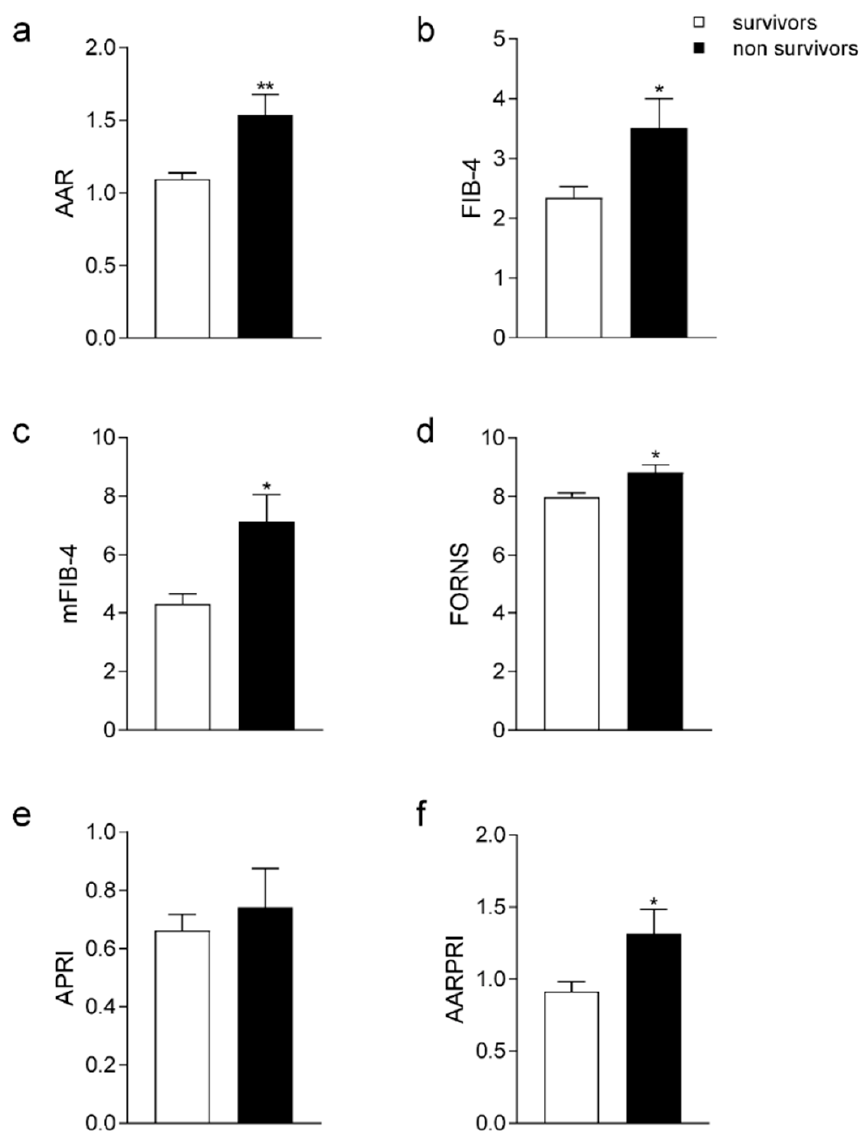
Figure 1. Comparison of Liver Fibrosis Scores in survivor and non survivor patients. Comparison of AAR ( a ), FIB-4 ( b ), mFIB-4 ( c ), FORNS ( d ), APRI ( e ), AARPRI ( f ) scores between survivors and non survivors. Data are presented as mean ± SEM. Statistical significance was assessed by Student t -test (* p < 0.05, ** p < 0.001). Abbreviations: AST to ALT ratio: AAR; fibrosis-4 index: FIB-4; modified FIB-4: mFIB-4; AST to Platelet Ratio Index: APRI; AAR to Platelet ratio: AARPRI. 3.2. Liver Fibrosis Scores among Discharged, Admitted to Intensive Care Unit (ICU),